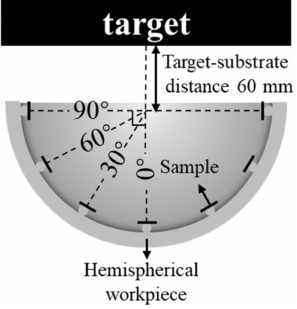
Figure 1. Schematic of the target, hemispherical workpiece, and sample